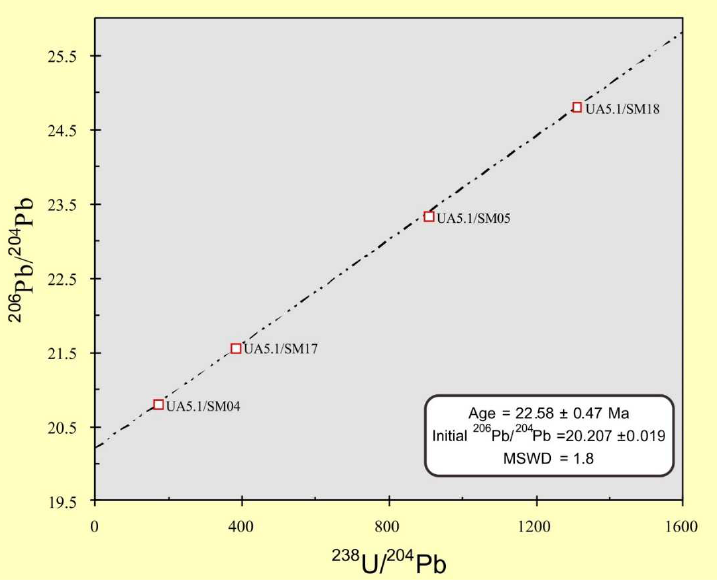
Figure 9. Uranium metallogenic age of the ferruginous sandstone. Table 5. Isochron age of U and Pb of ferruginous sandstone in Wajid Basin.